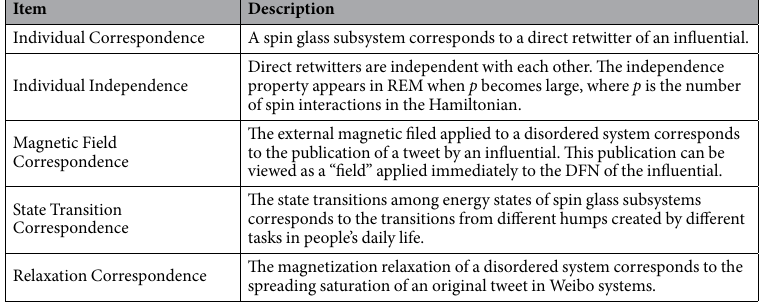
Table 1. Corresponding relationships between spin glasses and Weibo